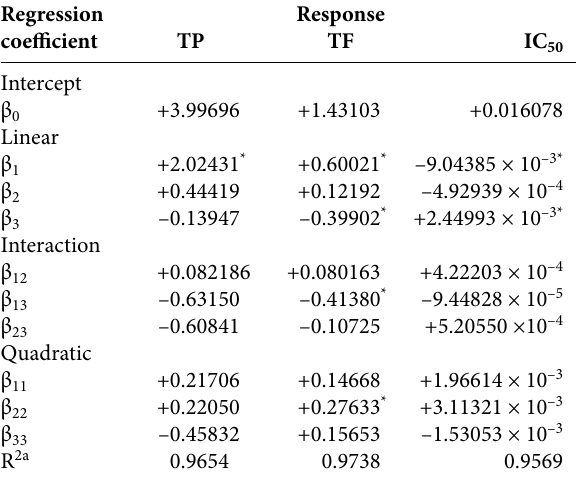
Table 3. Estimated coefficients of second-order polynomial models for investigated responses Regression